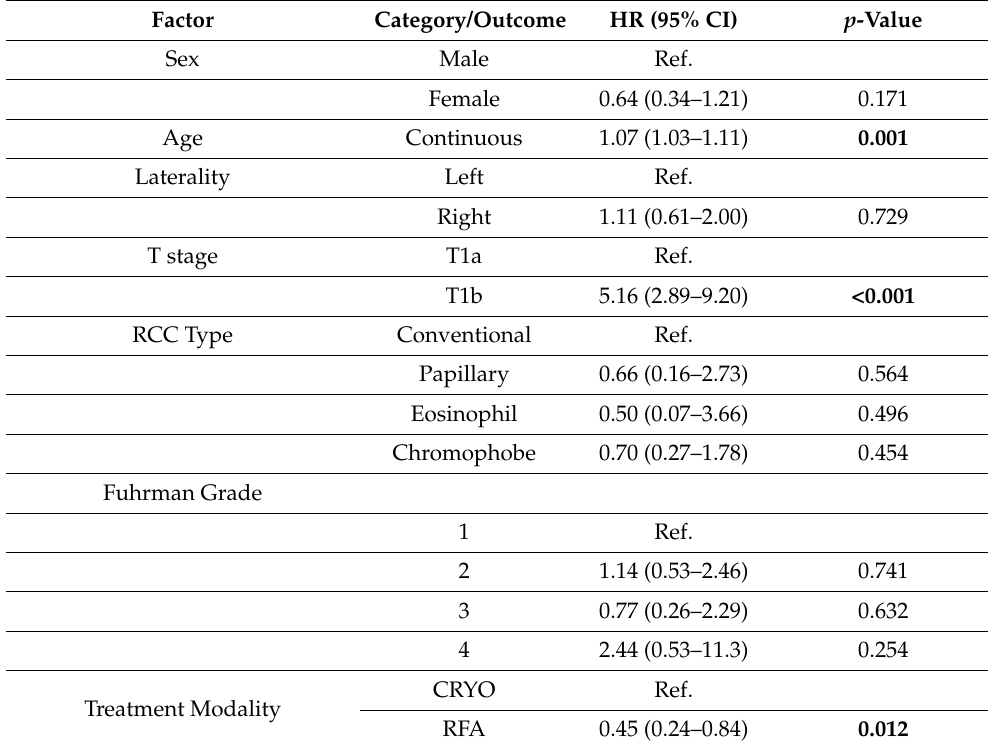
Table 2. Univariable analysis of prognostic factors and overall